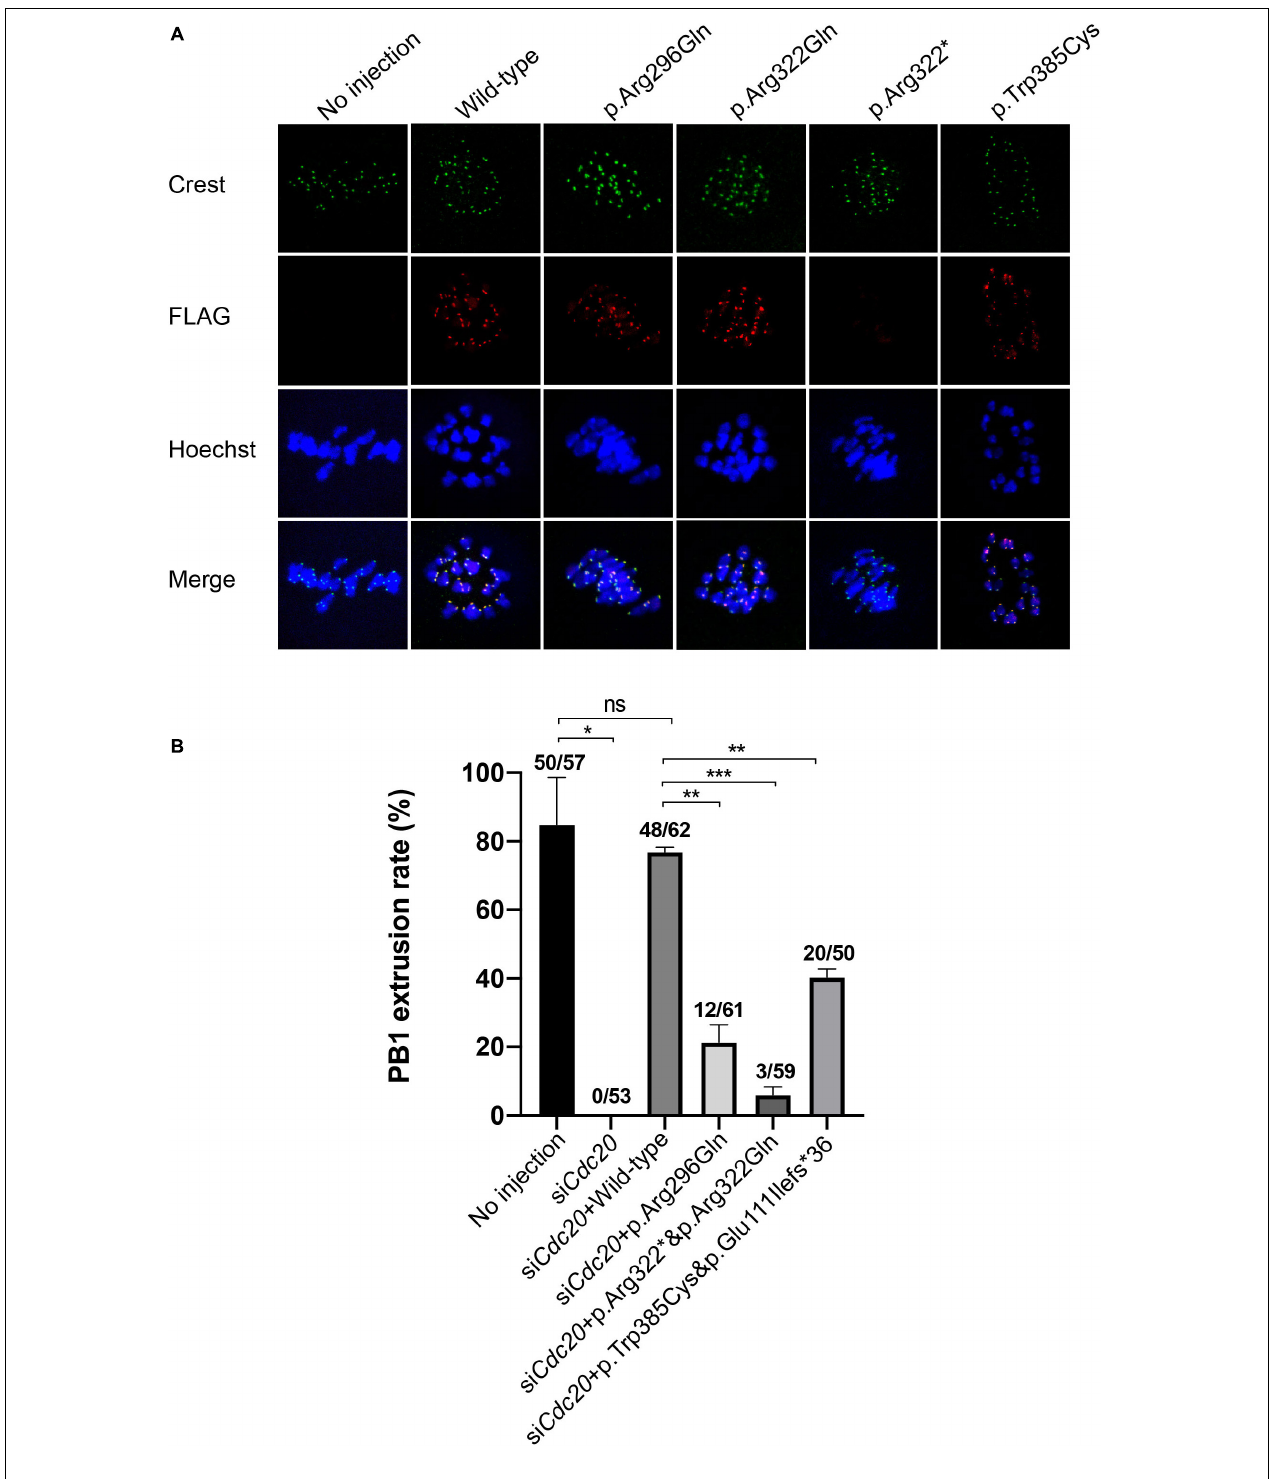
FIGURE 4 | Effects of the mutations on kinetochore localization in mouse oocytes and the CDC20 rescue ability in Cdc20 knockdown mouse oocytes. (A) Kinetochore localization of wild type and mutant FLAG-tagged CDC20 in mouse MI oocytes. Images were captured by confocal microscopy (Leica). Hoechst and Crest were used to label the DNA and kinetochores, respectively. (B) The effects of the mutations on the rescue of Cdc20 knockdown mouse oocytes. The number of oocytes with PB1 extrusion and the total number of oocytes used are listed at the top of the column. Significance was compared between the no injection group and the si Cdc20 group, the si Cdc20 coupled with wild-type CDC20 cRNA group, and the si Cdc20 coupled with mutant CDC20 cRNA groups. Two independent experiments were performed followed the chi-square test. * p < 0.05, ** p < 0.01, *** p < 0.001, ns, not significant.